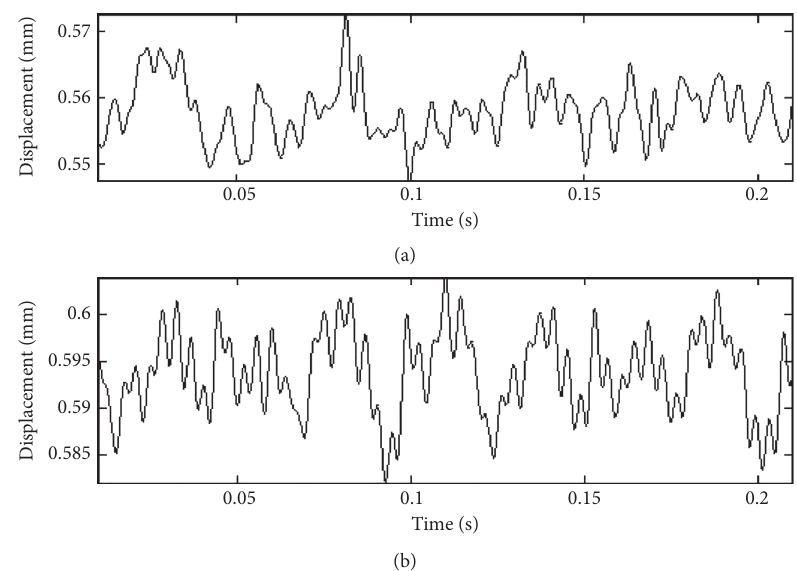
Figure 19: Axial position of the rotor. (a) The rotor was running at 6000rpm. (b) The rotor was running at